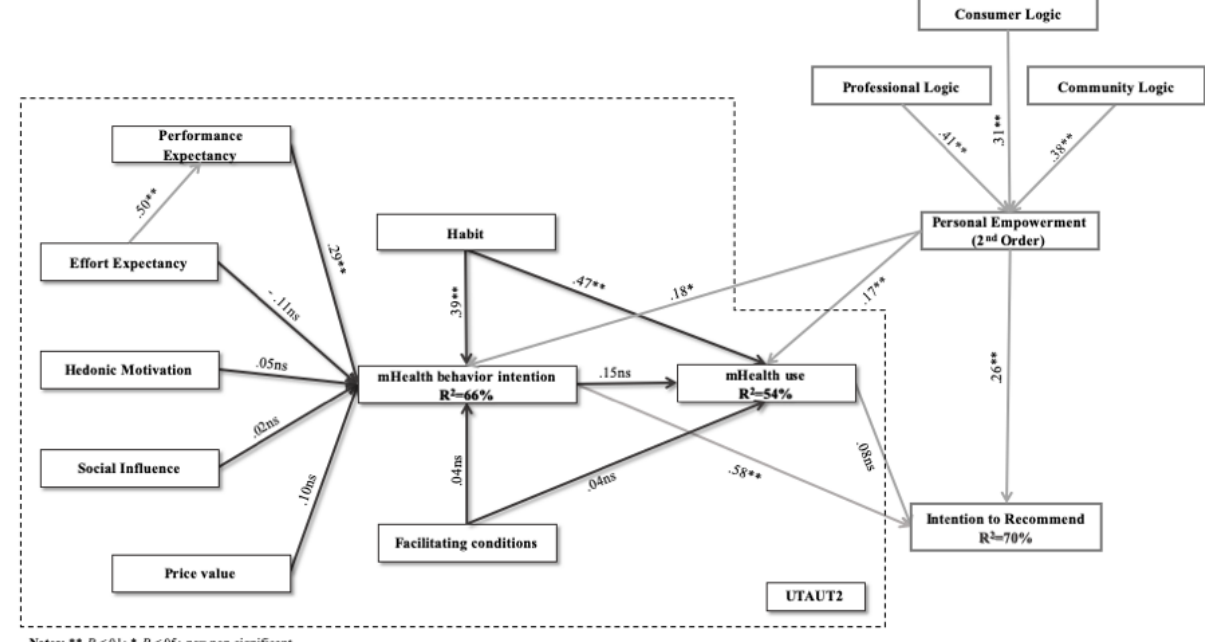
Figure 2. Results of the structural model for the total sample. UTAUT: unified theory of acceptance and usage of technology; mHealth: mobile health.